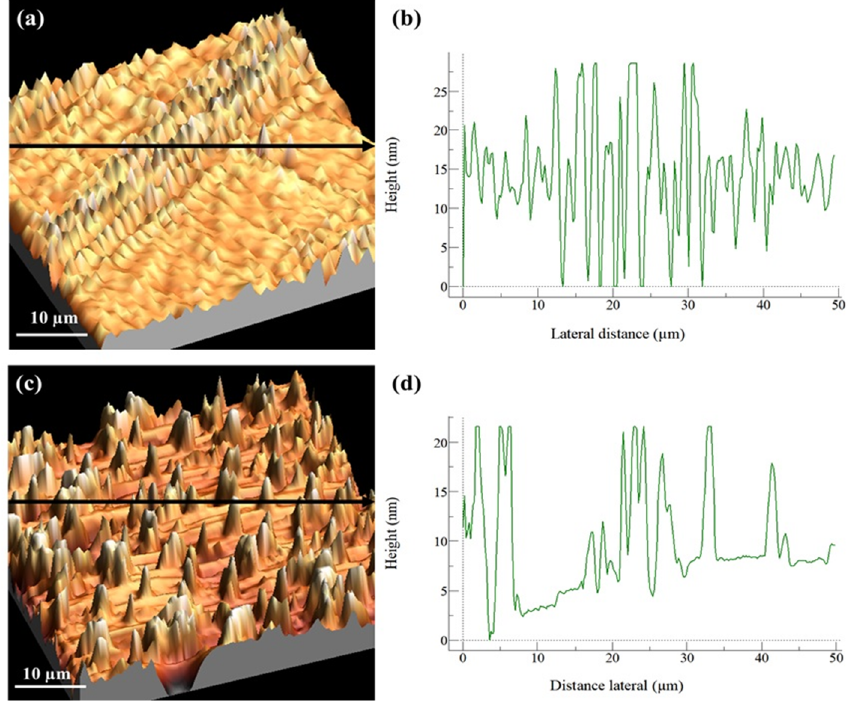
Figure 5. ( a , b ) u-PPO400/2000 membrane (70:30% w / w ) without DMA. ( a ) Three-dimensional topography in tapping-mode AFM. ( b ) Contour along the arrow in ( a ). ( c , d ) u-PPO400/2000 membrane (70:30% w / w ) with DMA. ( c ) Three-dimensional topography in contact-mode AFM. ( d ) Contour along the arrow in ( c ).